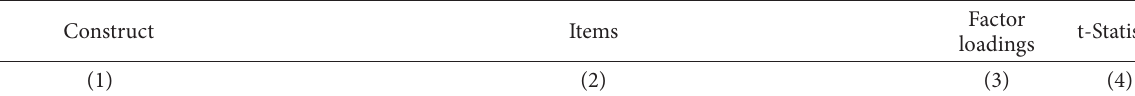
Table 4. Result for all reflective measurement